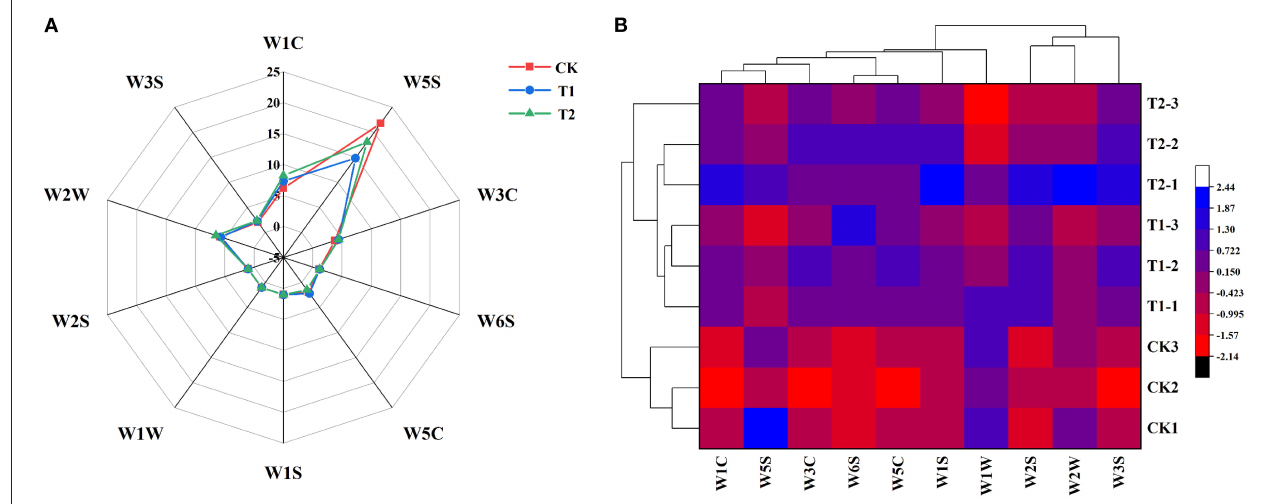
FIGURE 7 | Aroma characteristic response values (A) and HCA (B) of tomato fruits under different LED supplementary light periods. The data are expressed as average values ( n = 3). CK, no light supplementation control; T1, light supplementation for 3h in the morning; T2, light supplementation for 3h in the